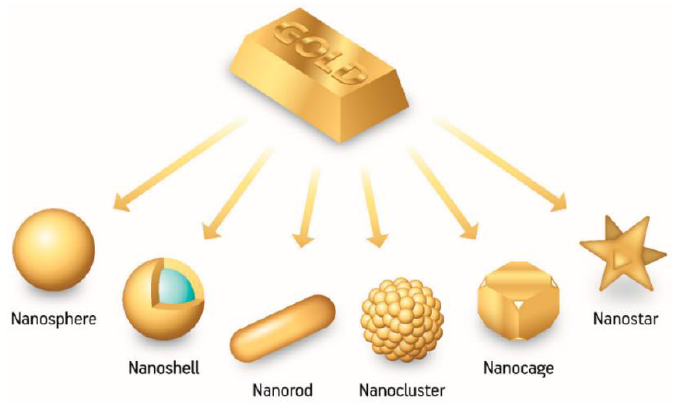
Figure 2. Visual representation of the most common Au NPs assemblies and morphologies in nanomedicine. Reproduced from [18], MDPI, 2018.